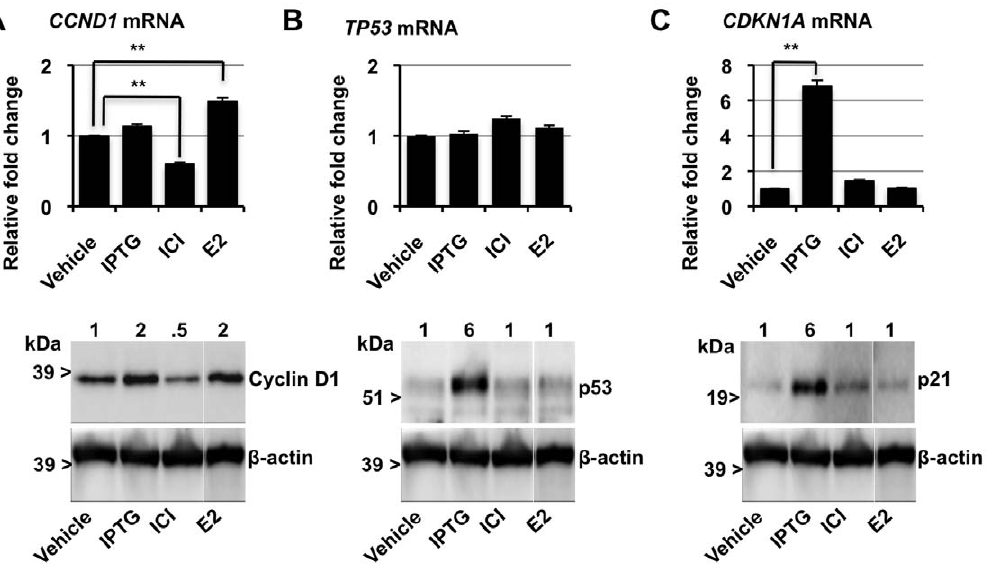
Figure 2. Regulation of cyclinD1,p53,andp21 mRNA and protein expression of in MCF-7p14ARF. Cells were treated with IPTG, ICI 182780 (ICI), or E2 for 12 h. Top panel: relative gene expression of A. CCDN1 , B. TP53 and C. CDKN1A mRNA quantified by qRT-PCR and relative expression normalised to control ACTB. Columns, Data represents the mean 6 SEM of three separate experiments (** P , 0.001. number=9). Bottom panel: representative Western blots of A. cyclin D1, B. p53, and C. p21. Relative levels of protein are shown above each lane. b -actin was used as a control. The representative images are all from the same sample set, run on the same gel and Western blot.